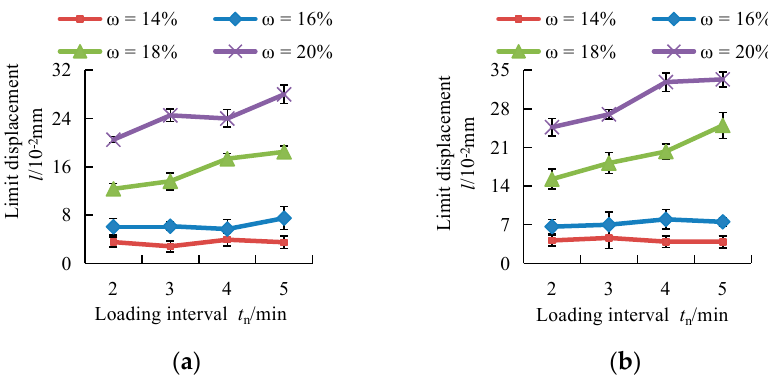
Figure 10. Effect of loading interval on limit displacement: ( a ) ρ d = 1.37 g/cm 3 ; ( b ) ρ d = 1.46 g/cm 3 .